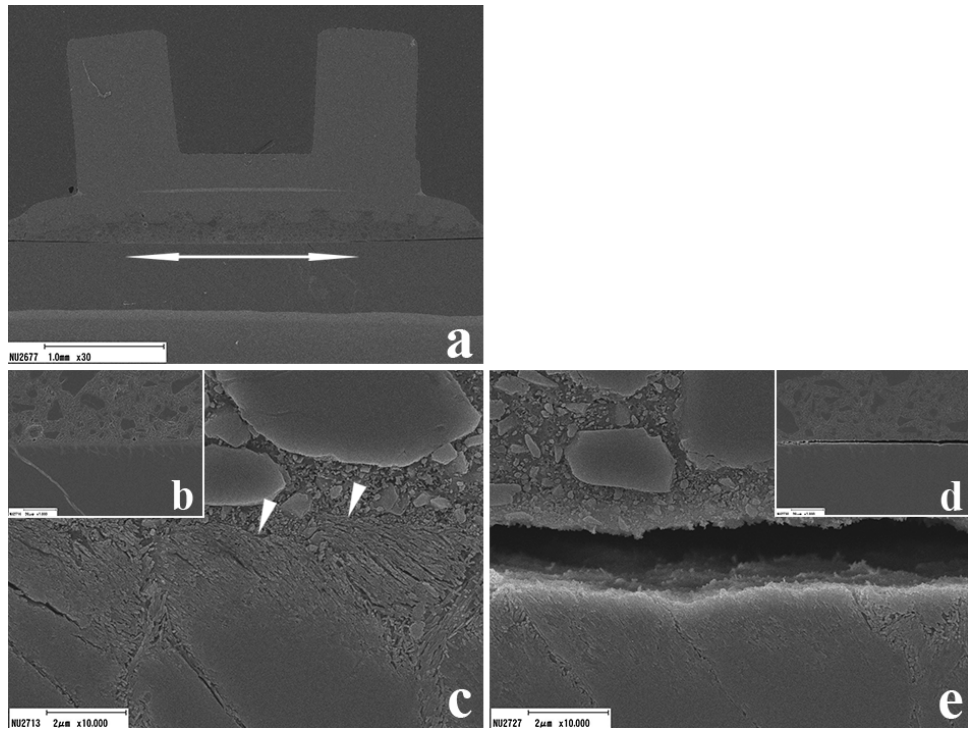
Figure 2. Representative SEM images of the orthodontic adhesive paste/enamel interface in TB. In the pre-etched area, excellent adaptation was observed (arrow), but gap formation was observed at both edges of the bracket base (( a ): magnification 30×). In the pre-etched region (( b ): magnification 1000×, ( c ): magnification 10,000×), compression of the enamel surface was observed (arrowheads). In the non-etched region, detachment between adhesive paste and enamel was observed (( d ): magnification 1000×, ( e ): magnification 10,000×).